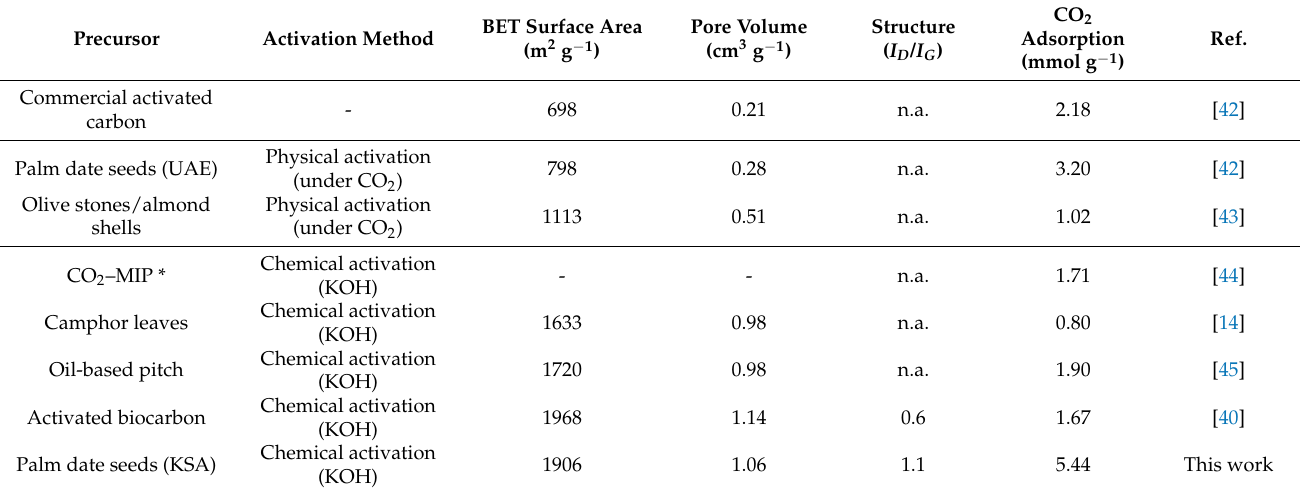
Table 3. The adsorbent performance of some activated porous carbon materials, generally derived from biomass, at 25 ◦ C and maximum CO 2 pressure of 1 bar. n.a. = not available. * MIP = molecularly imprinted polymers.